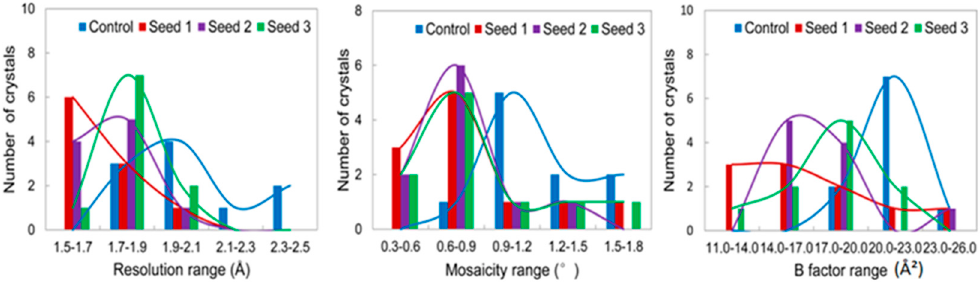
Figure 8. Comparison of the number of lysozyme crystals calculated by increases of ( a ) 0.2 Å in resolution range, ( b ) 0.3° in mosaicity range, and ( c ) 3 Å² in B-factor range.